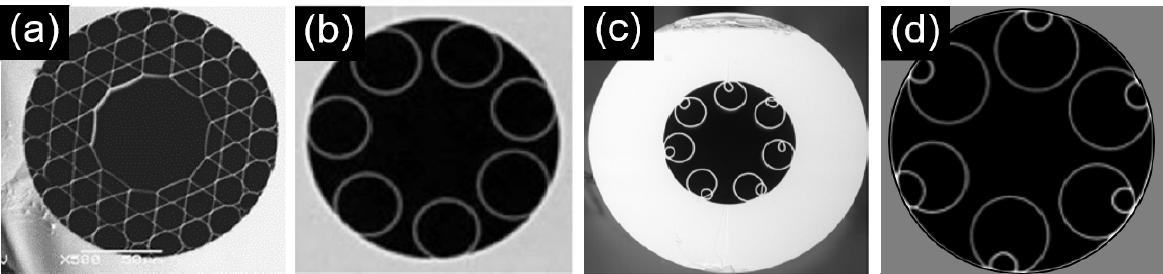
Figure 3. Scanning electron micrographs (SEMs) of AR-HCFs. ( a ) [Reprinted/Adapted] with permission from [16] © The Optical Society. ( b ) © 2017 IEEE. Reproduced with permission from Hayes et al., J. Lightwave Technol. 35, 437–442 (2017) [22]. ( c ) © 2017 IEEE. Reproduced with permission from Jose E. Antonio-Lopez et al., IEEE Photonics Conference (2017) [31]. ( d ) © 2020 IEEE. Reproduced with permission from Y. Hong, J. Lightwave Technol. 38, 2849–2857 (2020) [32].